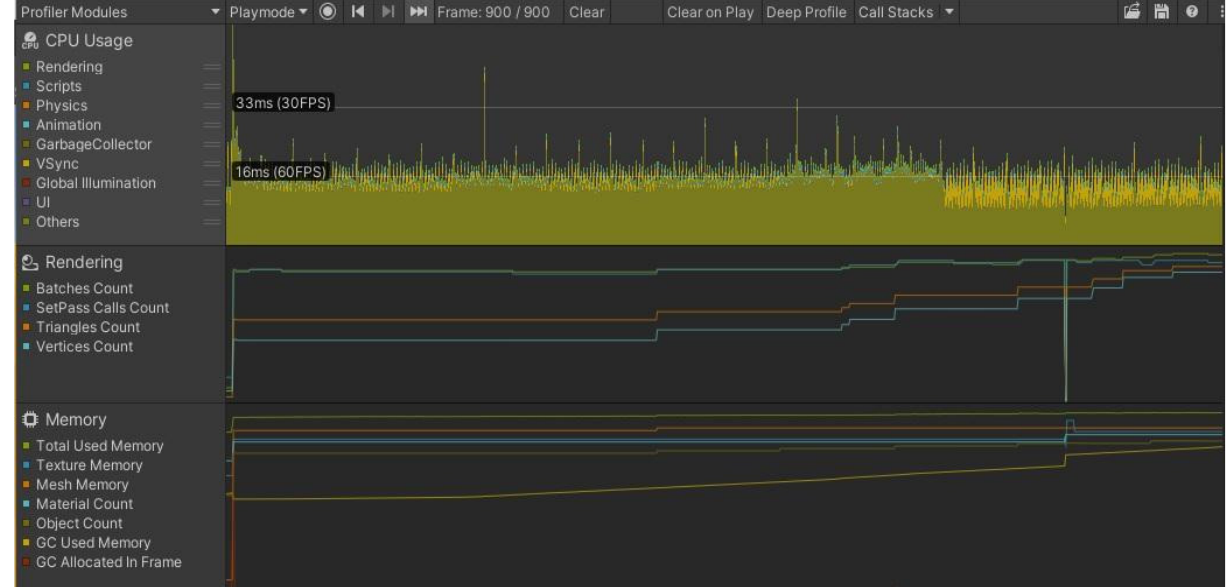
Figure 10. Profiler results for the beginning of the non-optimized version of the game.